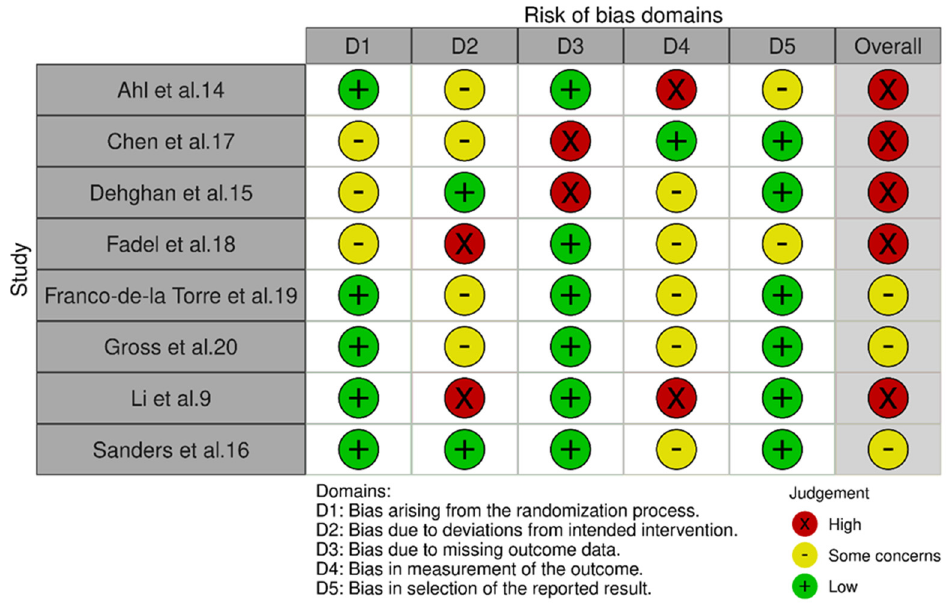
Figure 2. Randomized controlled trials risk of bias.